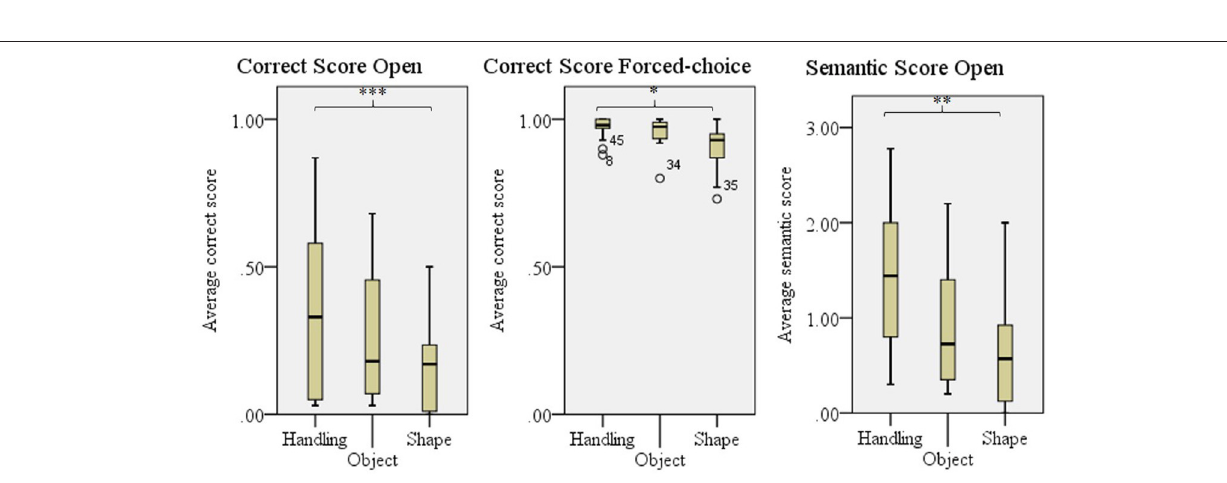
Frontiers in Psychology |